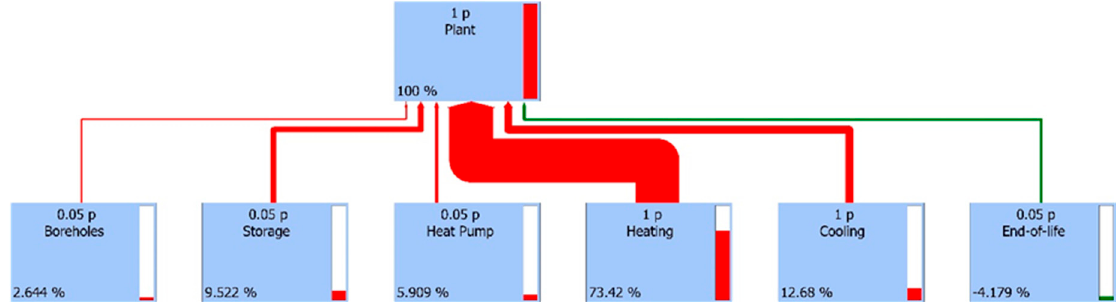
Figure 4. Typical tree view of the system life cycle (shown as global warming for the PCM-uTES scenario with energy from the grid).